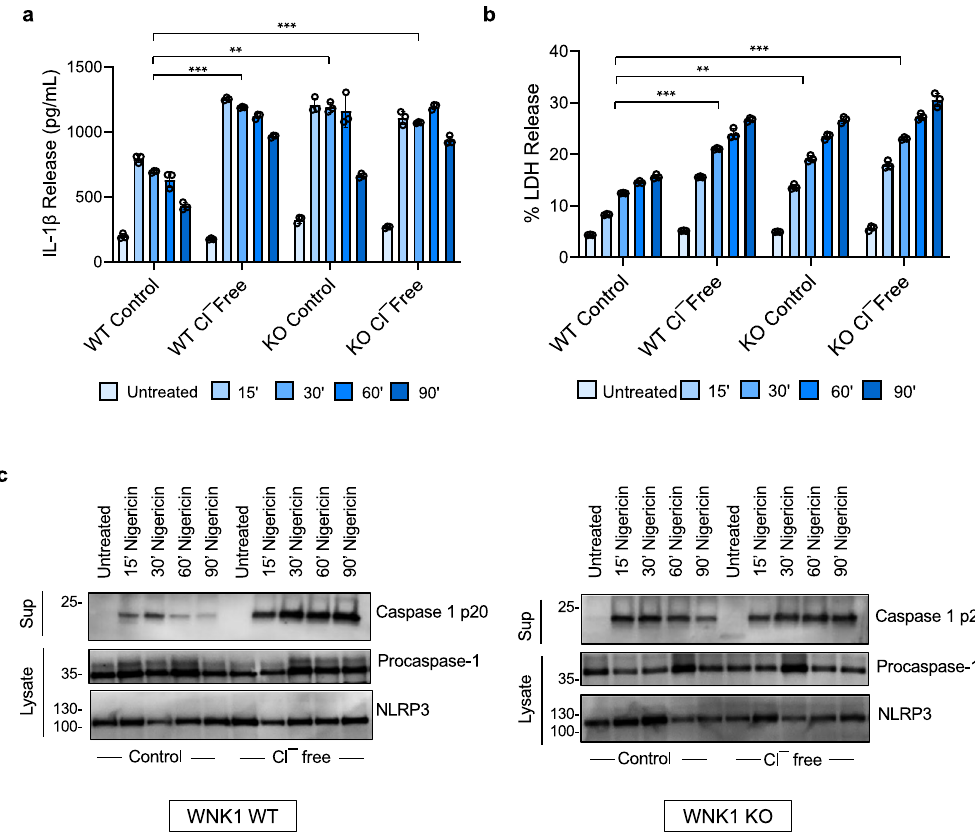
Fig. 5 WNK1 regulates NLRP3 in fl ammasome activation by a Cl − -sensing mechanism. IL-1 β ( a ) and LDH ( b ) release in culture supernatants of LPS- primed (4 h) primary Wnk1 + / + LysMCre + (WNK1 WT) and Wnk1 fl ox/ fl ox LysMCre + (WNK1 KO) BMDMs reperfused with the indicated isotonic salt solution for 1 h prior to stimulation with nigericin for the indicated times. P values in a are 0.000255, 0.001413, and 0.00003; b are 0.00018, 0.00229, and 0.000208. c Immunoblots of caspase-1 p20 released in culture supernatants (Sup) or procaspase-1 and NLRP3 in cell lysates (Lysate) of LPS-primed (4 h) primary Wnk1 + / + LysMCre + (WNK1 WT) and Wnk1 fl ox/ fl ox LysMCre + (WNK1 KO) BMDMs reperfused with the indicated isotonic salt solution for 1 h prior to stimulation with nigericin for the indicated times. Results are representative of at least three independent experiments performed in duplicate or triplicate. Error bars in a and b are presented as mean values± standard deviation (S.D.). with n = 3. Two-sided Student ’ s t test, ** p < 0.005, *** p <